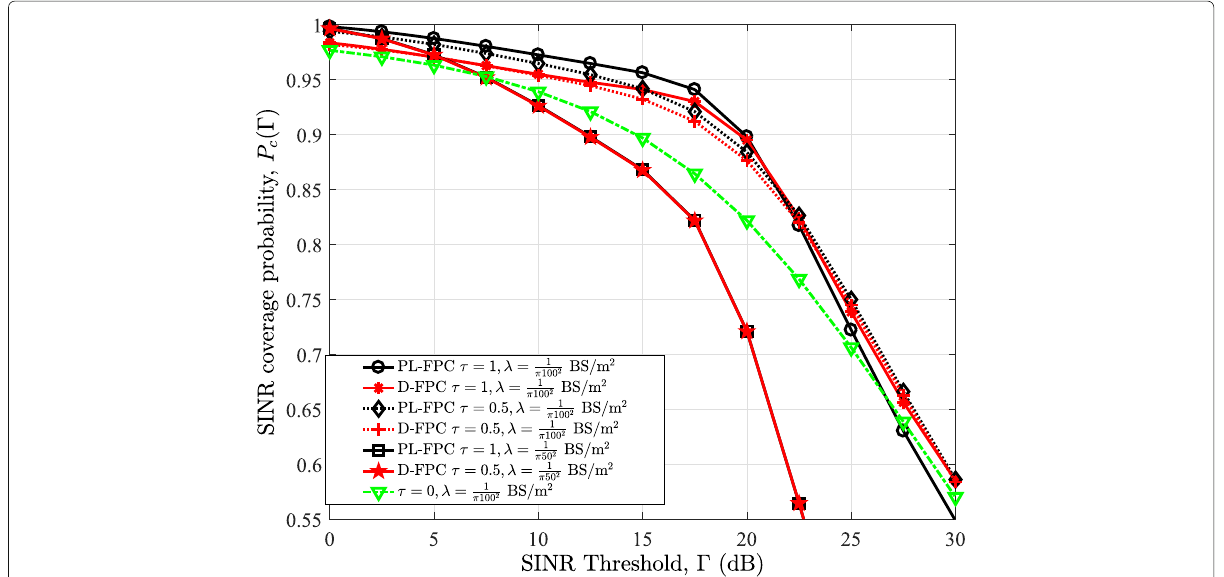
Fig. 7 Comparison of the SINR coverage probability based on the PL-FPC and the D-FPC in the uplink of mmWave cellular